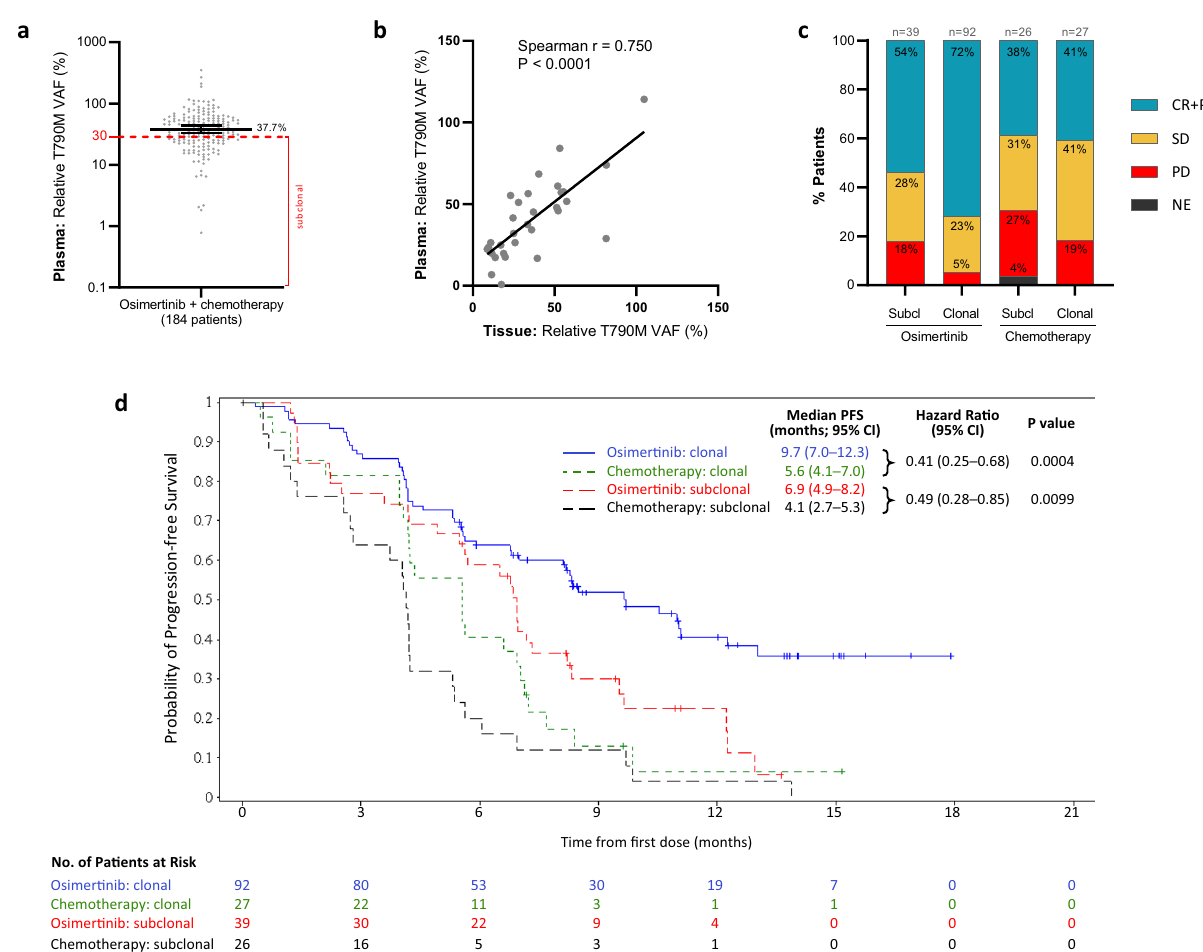
Fig. 2 T790M clonality levels in baseline plasma and its association with tumour response and progression-free survival (PFS) on osimertinib and chemotherapy. a Distribution of relative T790M VAF in 184 selected AURA3. Black line represents the median (37.7%), ticks mark 95% CI (33.0 – 43.8%); red dashed line marks 30% T790M subclonality threshold. b Correlation between relative T790M VAF values calculated from plasma and tissue NGS data from 31 AURA3 patients for which both values were available. Spearman correlation = 0.750; P value = 0.0000012. c Patient ’ s best objective response (BOR) depending on the T790M subclonality group and treatment arm. BOR assessed according to Response Evaluation Criteria in Solid Tumours (RECIST). Relative T790M VAF of 30% was chosen as a subclonality threshold. CR + PR complete and partial response, SD stable disease, PD progressive disease, Subcl T790M subclonal, Clonal T790M clonal. d Kaplan – Meier estimates of the duration of PFS in subpopulations of patients with T790M subclonal and clonal tumours treated with osimertinib or chemotherapy. The tick marks indicate censored data. A hazard ratio <1 favours osimertinib. The HR, its two-sided 95% CI and P value are obtained from the unadjusted Cox proportional L858R and T790M mutations in baseline plasmas (Supplemen- tary Fig. 6a, b).